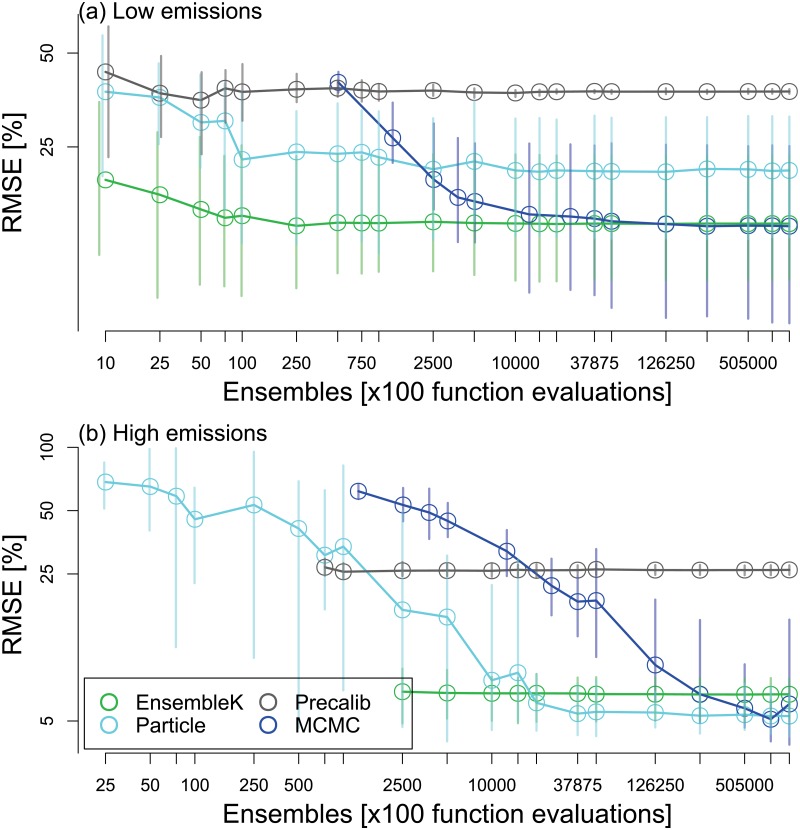
Performance as a function of ensemble size.Performance of four data assimilation methods as a function of the number of ensembles. The performance is expressed as root mean squared error (RMSE) between observed and forecasted phosphorus states scaled relative to the observed mean phosphorus levels across the entire time period (y-axis). RMSE is shown as a function of the number of ensembles, particles, samples, or chain length, together termed ensembles (x-axis), for the EnKF, PF, PC, and MCMC methods, respectively. Markers (vertical lines) show the mean (range) of RMSE estimates across 10 random sets of 100 year observations generated using the same assumed truth. Results are shown for (a) low, and (b) high emission strategies.